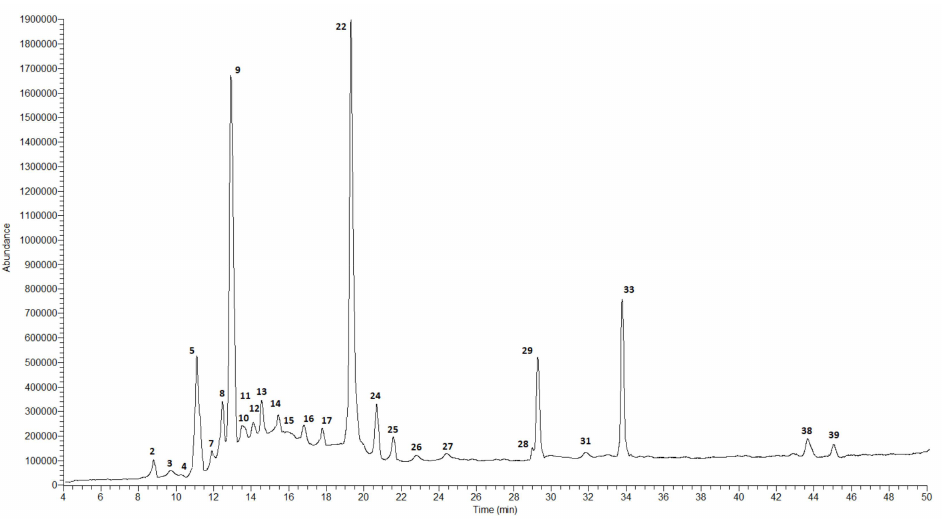
Figure 4. LC-MS chromatogram in SCAN mode for 60% ethanol extract from the fruits of C. roseus